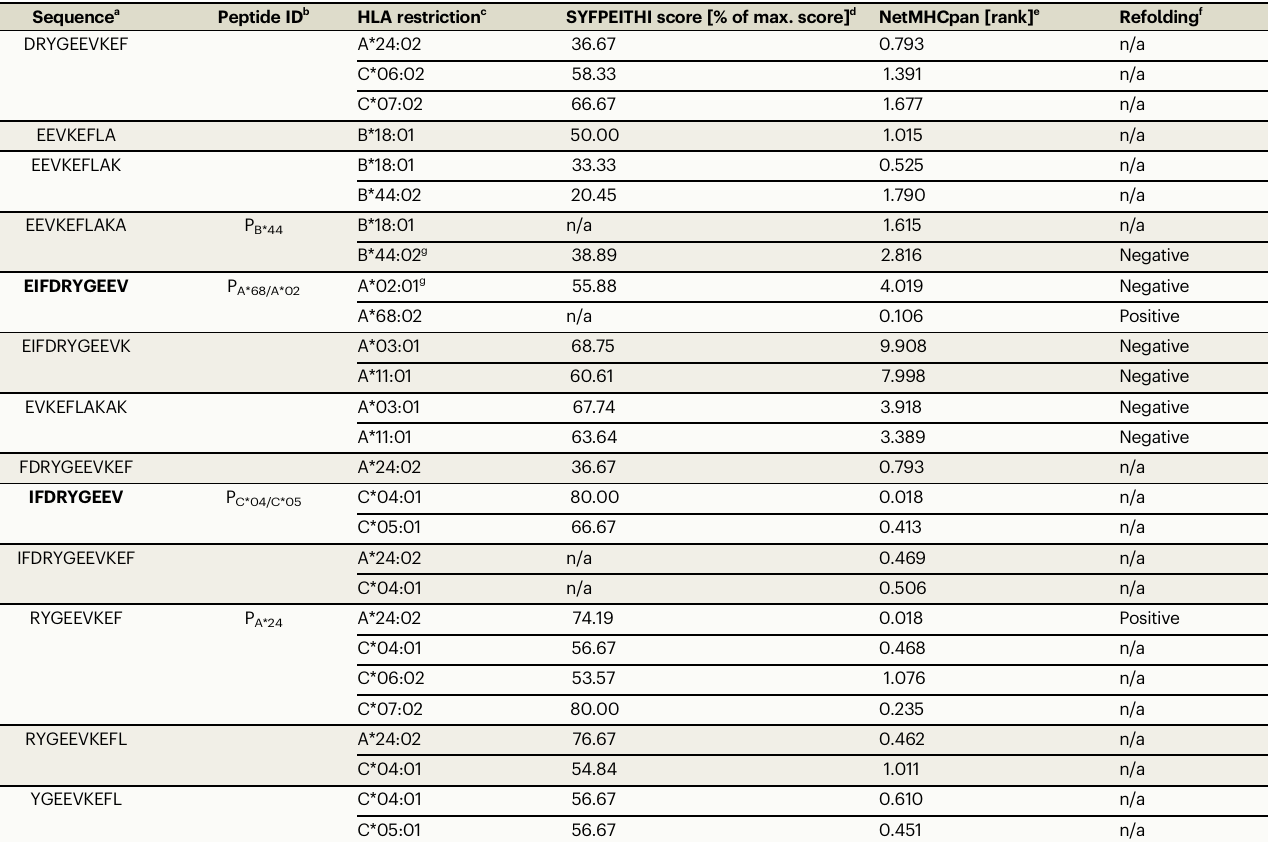
Insilicopredictedandmassspectrometricidenti fi ed(bold)HLAclassIligandsderivedfromtheDNAJB1-PRKACAfusionprotein.PredictionswereperformedwithSYFPEITHI1.0andNetMHCpan4.1 forthe 20most frequentHLA classI allotypes intheEuropean population (tools.iedb.org).